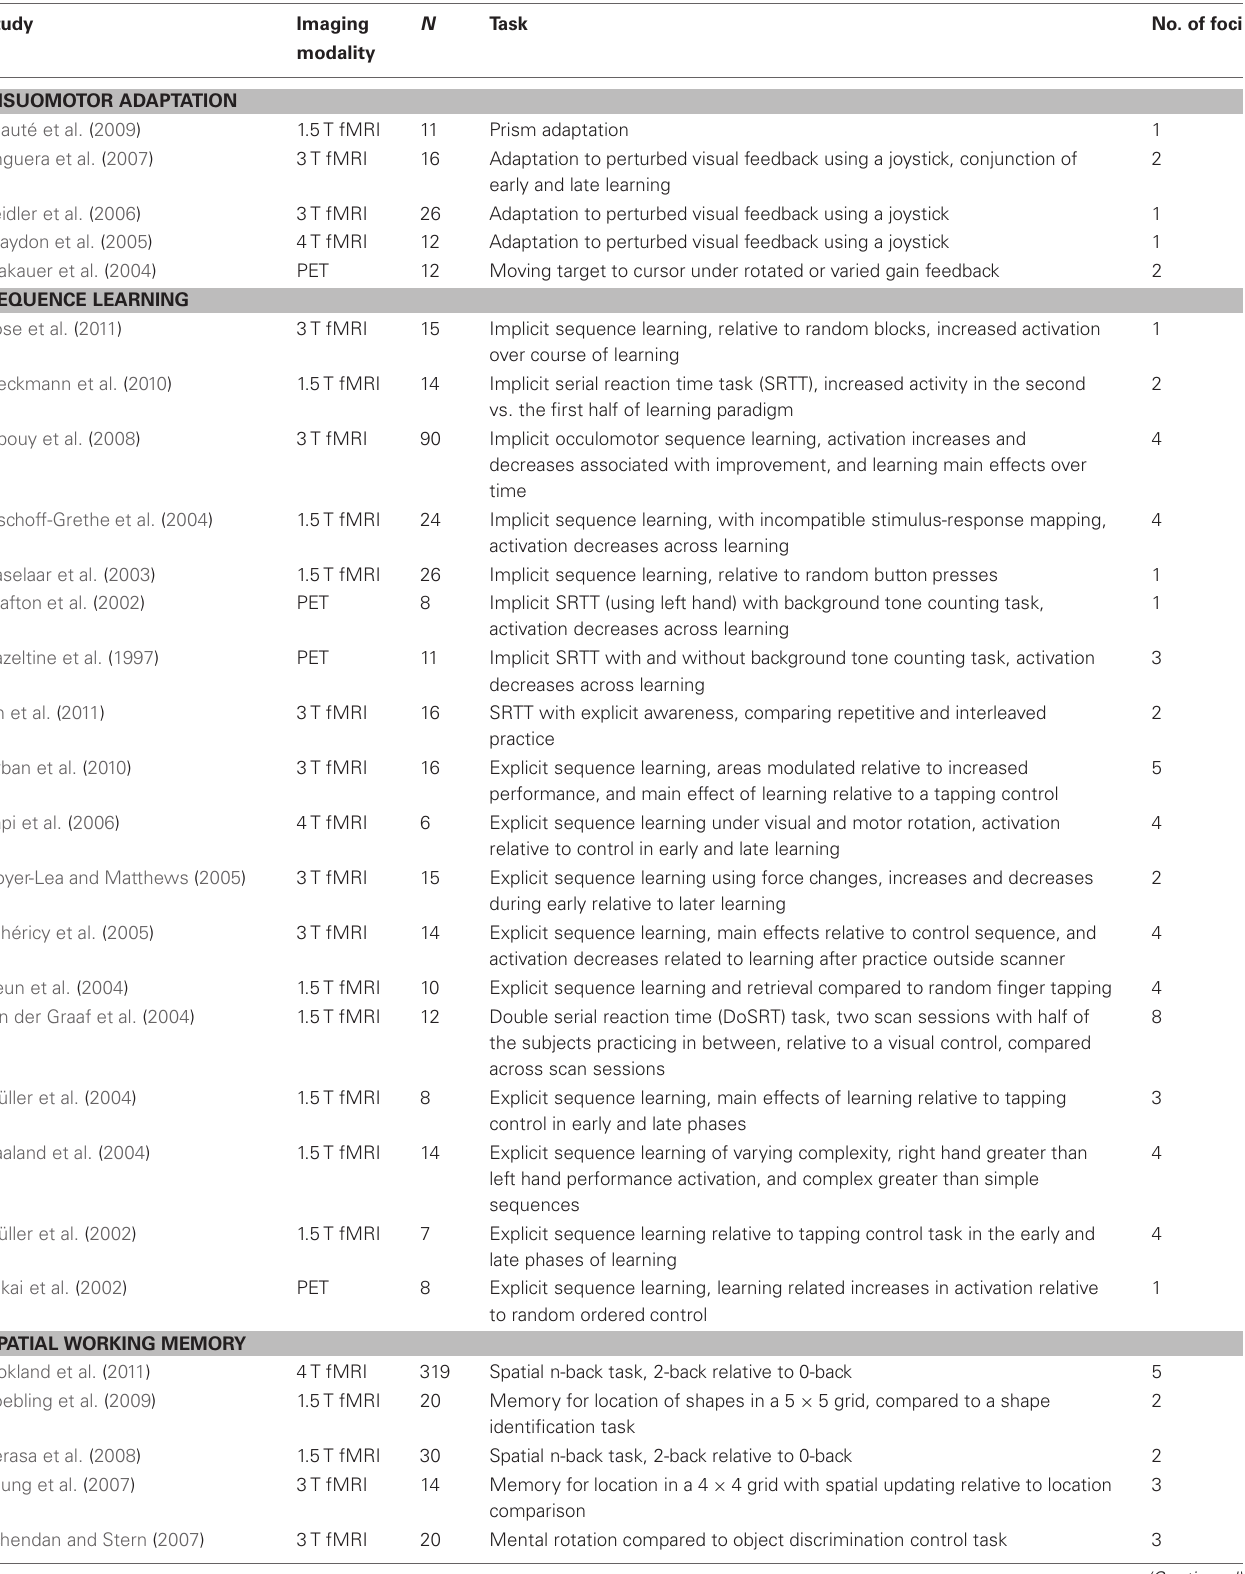
Table 1 | Studies included in the meta-analysis, organized by